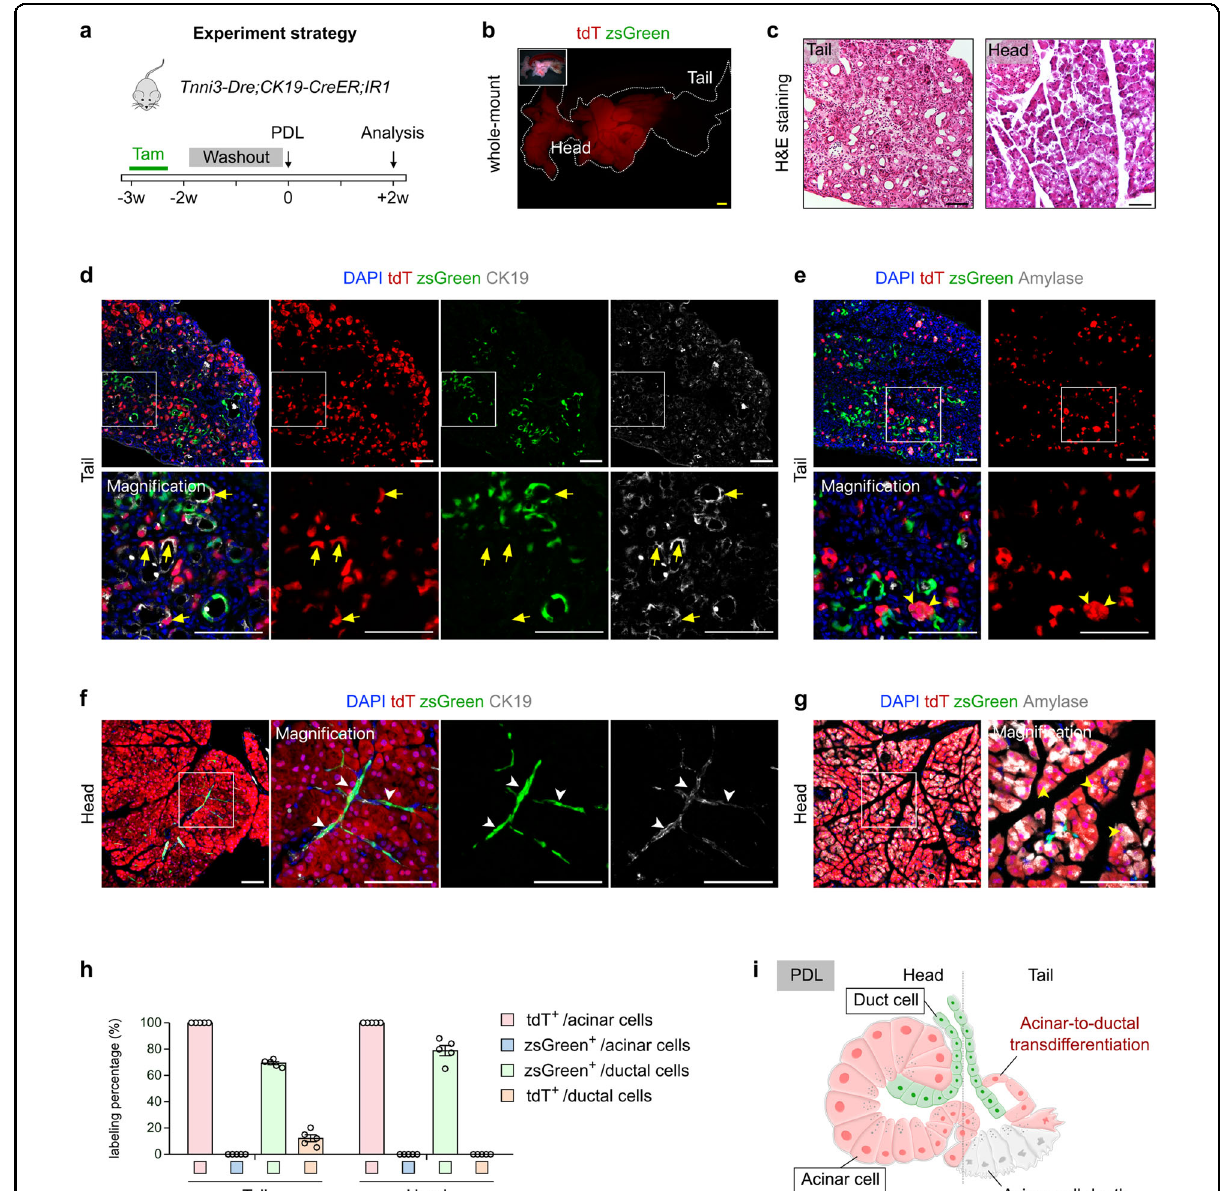
Fig. 5 Acinar-to-ductal transdifferentiation occurs after pancreatic duct ligation-induced injury. a Schematic diagram illustrating the experimental strategy for Tam treatment, PDL-induced injury and analysis. b Whole-mount bright- fi eld and fl uorescent images showing zsGreen and tdT expression in the pancreas from Tnni3-Dre;CK19-CreER;IR1 mice after PDL-induced injury. c H&E staining of pancreatic sections from indicated mice. d , e Immunostaining for tdT, zsGreen and CK19 ( d ) or Amylase ( e ) on sections collected from the tail region of PDL pancreas. Yellow arrows, tdT + duct cells. Yellow arrowheads, tdT + acinar cells. f , g Immunostaining for tdT, zsGreen and CK19 ( f ) or Amylase ( g ) on sections collected from the head region of PDL pancreas. White arrowheads, zsGreen + duct cells. Yellow arrowheads, tdT + acinar cells. h Quanti fi cation of the percentage of duct cells expressing zsGreen or tdT and acinar cells expressing zsGreen or tdT in the tail and head regions of pancreas from Tnni3-Dre;CK19-CreER;IR1 mice after PDL-induced injury. Data are means ± SEM. n = 5. i Diagram illustrating that a subset of new duct cells in the injury region is derived from tdT + acinar cells after PDL. Scale bars, yellow, 1 mm; white and black,100 μ m. Each image is representative of 5 individual